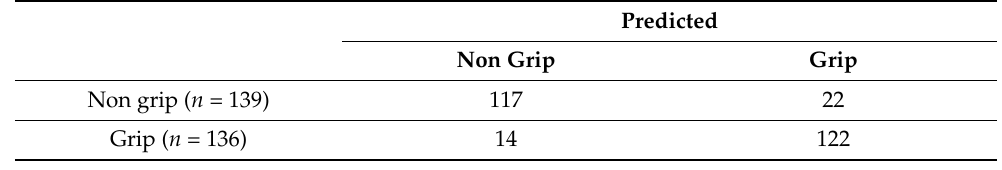
Figure 3. Labeling of the “grasp” or “not grasped” frame.